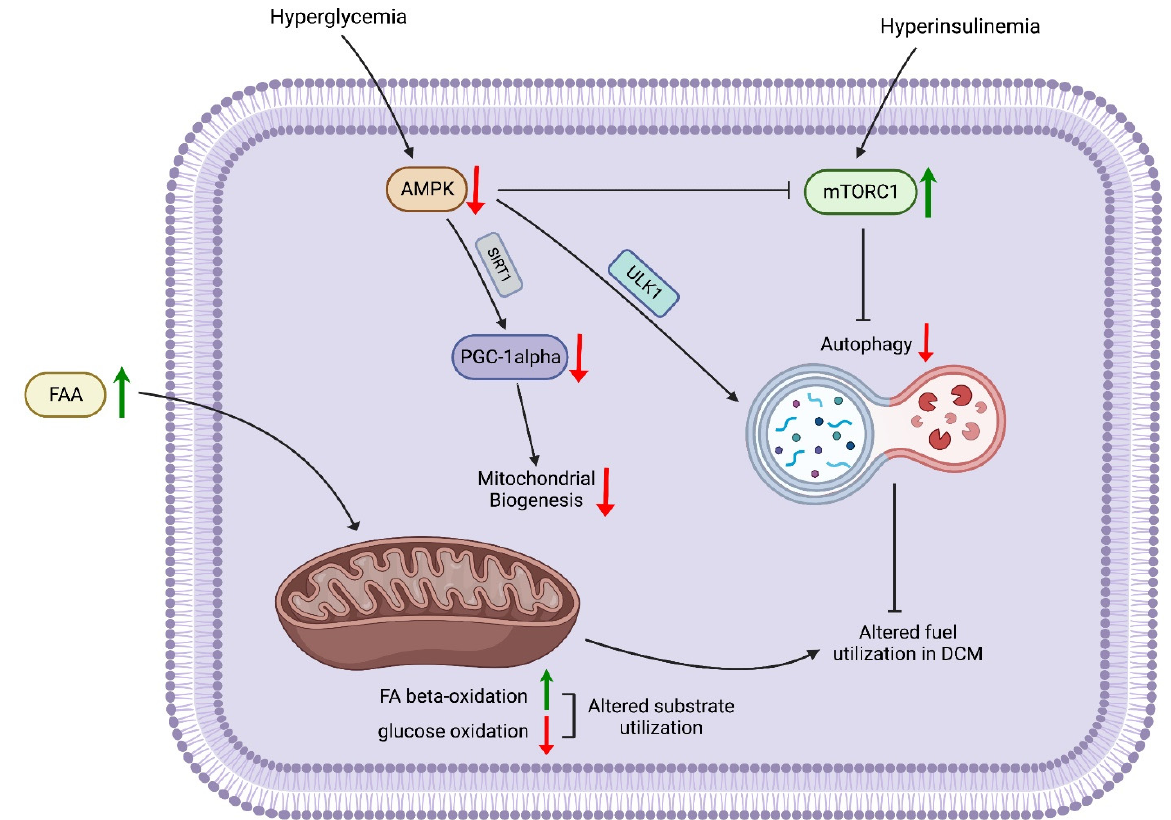
Figure 1. Impaired nutrient-sensing signaling, dysregulated autophagy, impaired mitochondrial energetics, and altered fuel utilization in the pathogenesis of diabetic cardiomyopathy. AMPK:5’ adenosine monophosphate-activated protein kinase; mTORC1: mammalian target of rapamycin complex 1; ULK1: unc-51-like autophagy activating kinase 1; PGC-1 á : peroxisome proliferator-activated receptor-gamma coactivator 1-alpha; FFA: fatty acid, DCM: diabetic cardiomyopathy.